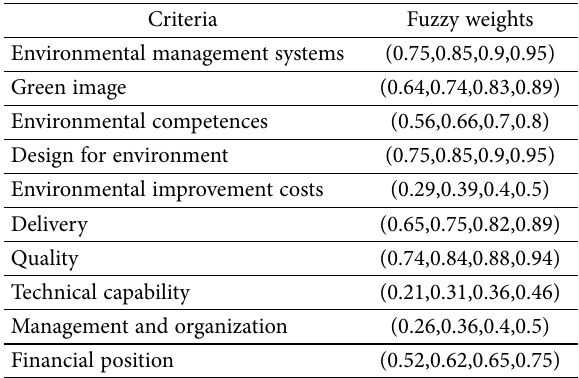
Table 5. Evaluation criteria and their average fuzzy weights